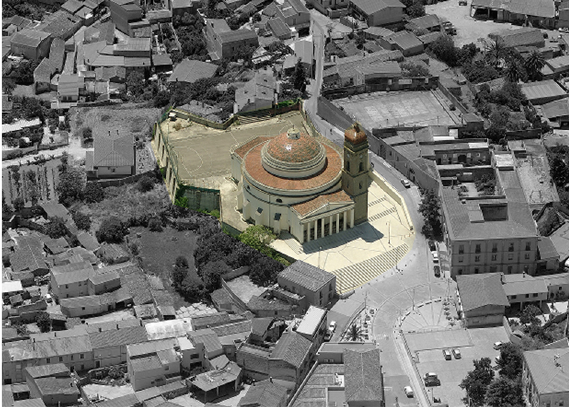
Figure 1. Aerial view of the Basilic (Pilia E.).